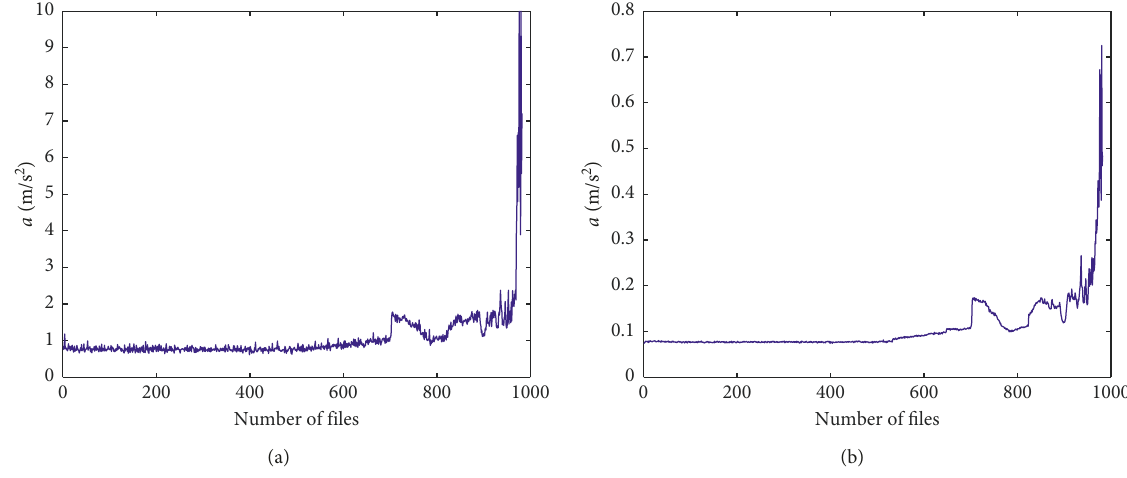
Figure 3: The peak-to-peak (a) and RMS (b) of the whole life of Case Discrete Fréchet distance of curves P and Q : 1.8983